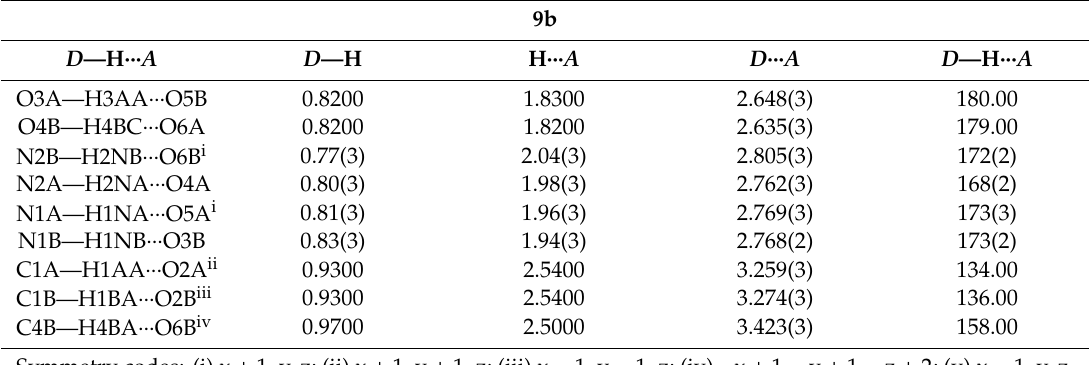
Figure 4. Molecular packing for benzimidazole 10f, showing hydrogen bonds that were drawn as dashed lines along the b axis. Table 2. Hydrogen-bond geometry (Å, °) for 9b and 10f 9b.